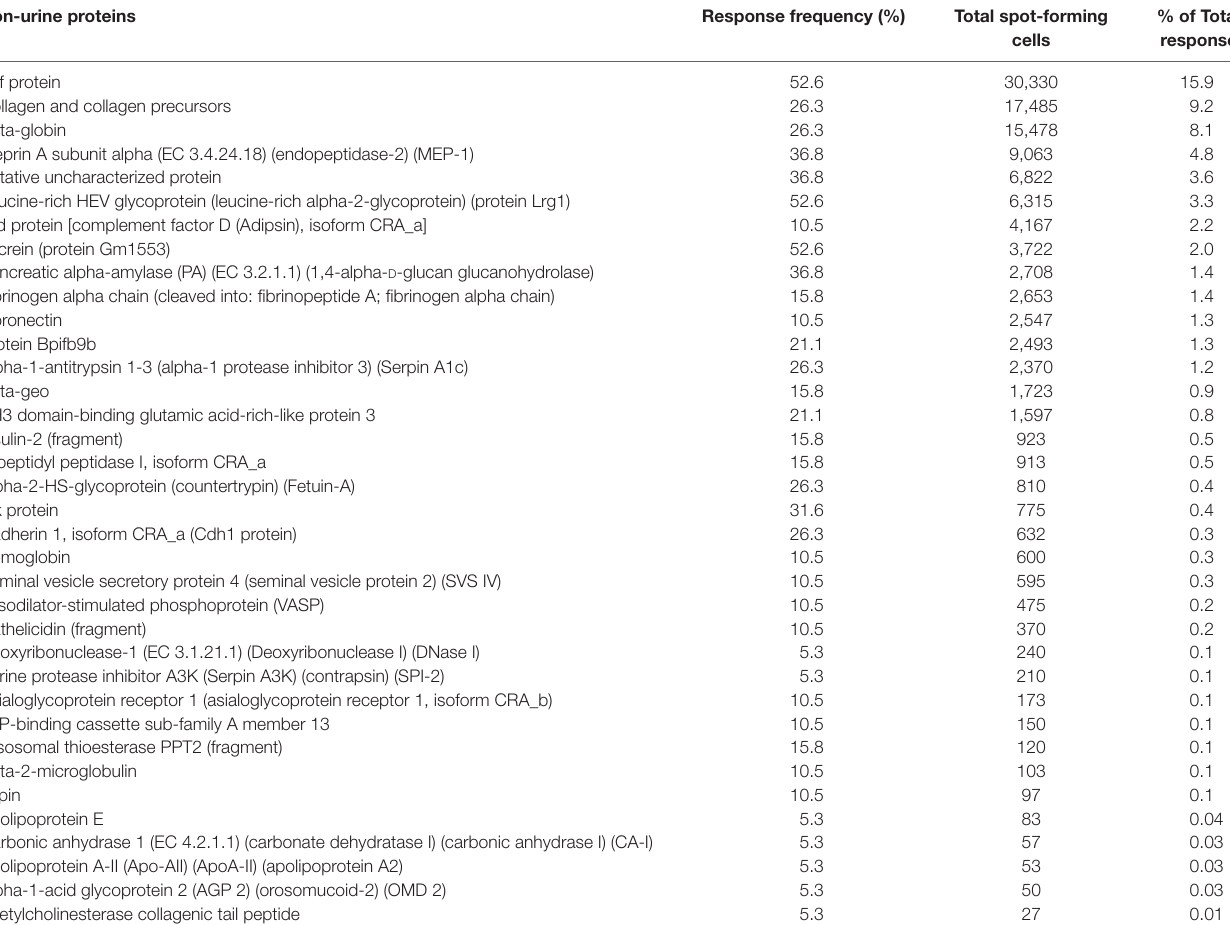
TaBle 2 | Protein sources of non-urine reactive peptides. non-urine proteins response frequency (%)